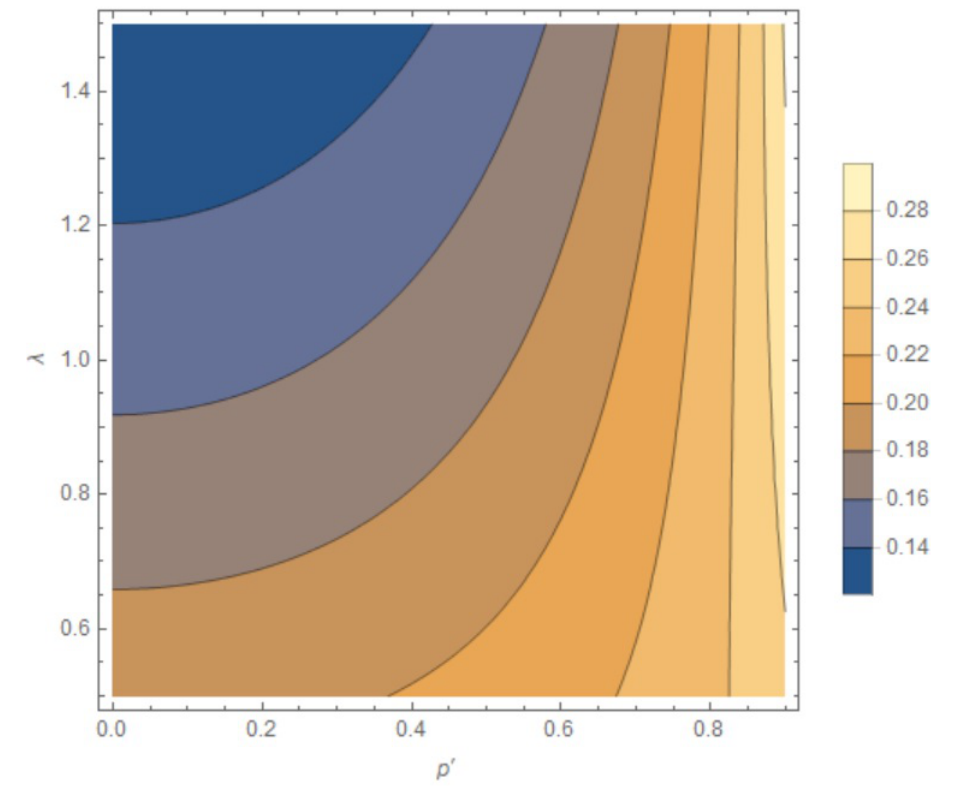
Figure 17. Probability density function for a free Euclidean particle as function of p (cid:48) and λ .